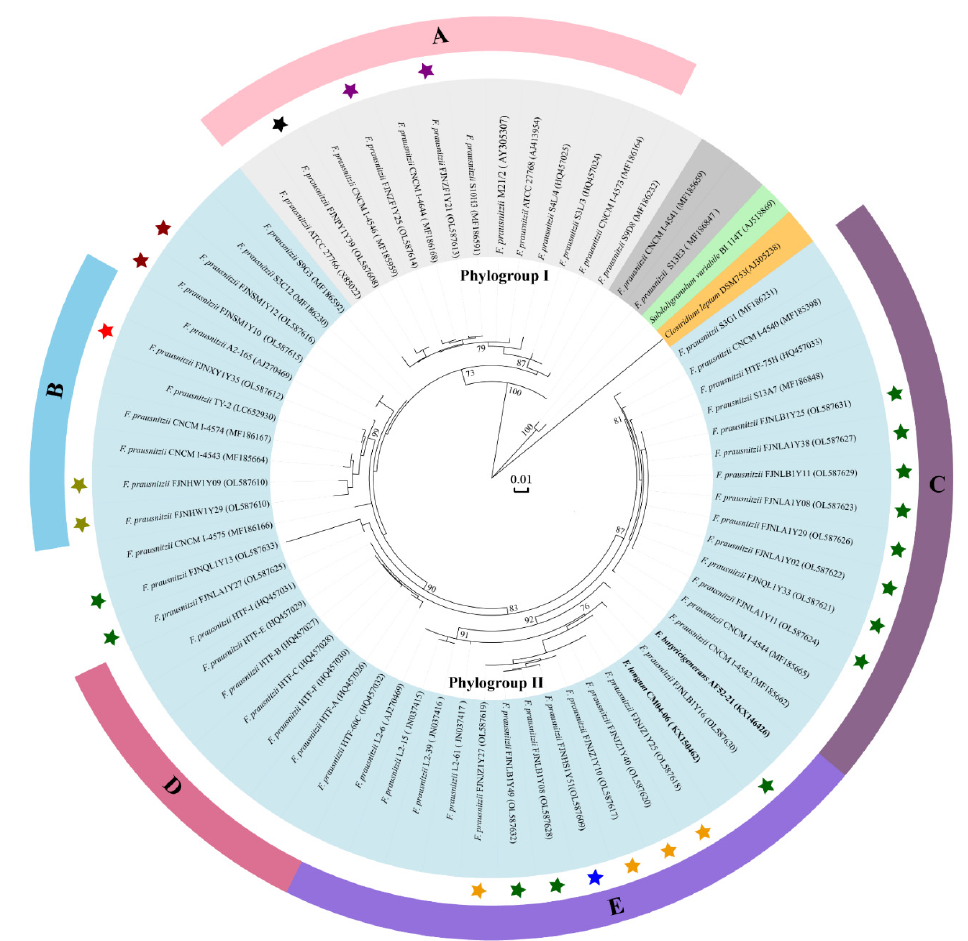
Figure 3. Phylogenetic tree of F. prausnitzii strains based on 16S rRNA gene sequences. The rooted tree was constructed with the MEGA7 software package using the maximum likelihood method. Clostridium leptum DSM 753 was used as an out-group. Bootstrap values higher than 70% are shown at the branching points. Background colors indicate different categories (light grey, phylogroup I; light blue, phylogroup II; grey, unclustered branches; light green, other genera from oscillospiraceae family; orange, out-group). The F. prausnitzii strains isolated in the present study were marked with stars (isolates derived from the same donor were presented with the same color). Colors and letters (A, B, C, D, and E) represent the tree subgroups formed by our isolated strains. The bold characters indicate type strains of two newly identified species ( F. longum and F. butyricigemerams ) of genus Faecalibacterium .